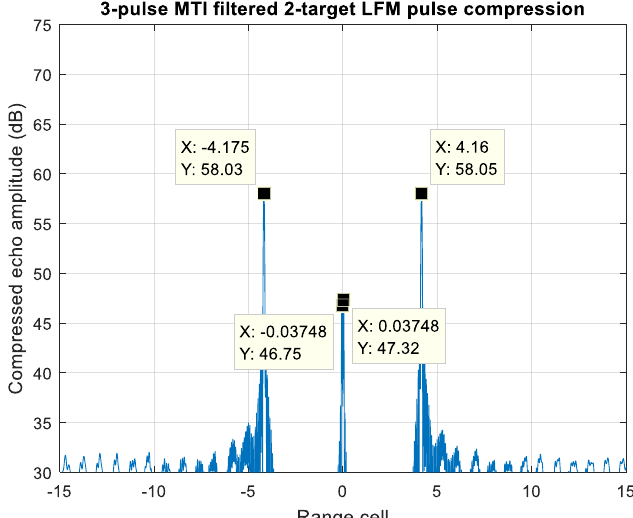
Figure 24. A 3-pulse MTI filtered echo of two overlapped targets. Target one is near-zero-Doppler, while the target-two velocity is at Mach 15. while the target-two velocity is at Mach